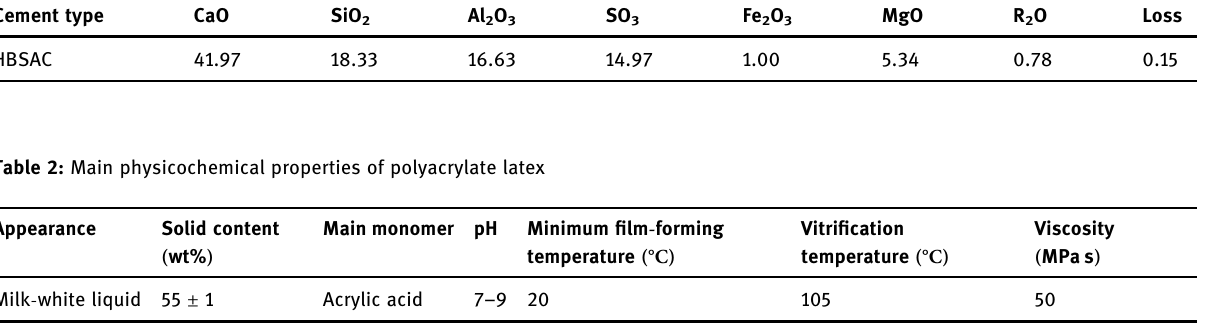
Table 1: Main chemical composition of HBSAC Cement type